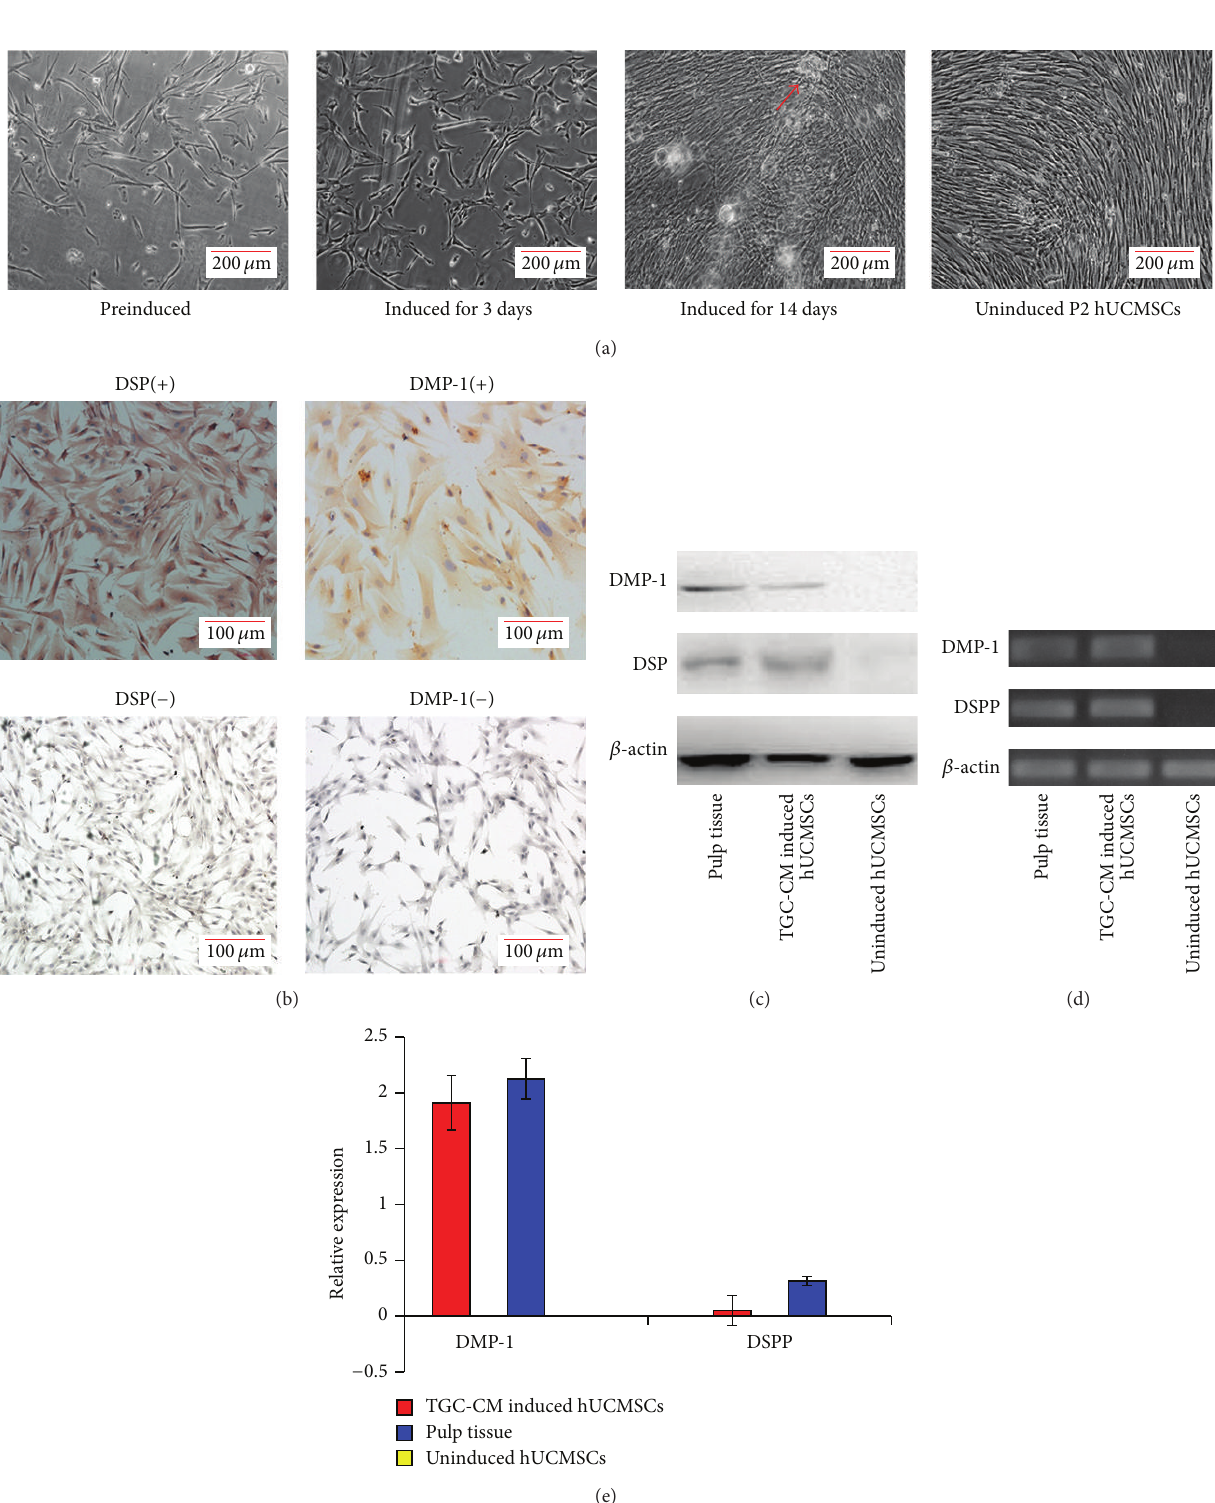
Figure 2: TGC-CM induces hUCMSCs into odontoblast-like cells in vitro . (a) After hUCMSCs were induced in TGC-CM for 3 days, there was little change in the cell morphology. After 14 days, the TGC-CM-induced hUCMSCs grew well and calcified areas were observed (arrow), but the morphology was similar to uninduced cells. (b) Odontoblast marker proteins DSP and DMP-1 were detected in TGC-CM-induced hUCMSCs by immunocytochemistry, but not in uninduced hUCMSCs. (c) Western blotting showed that TGC-CM-induced hUCMSCs and pulp tissue expressed DMP-1 and DSP, whereas uninduced hUCMSCs did not express these proteins. (d) and (e) Relative mRNA levels of DMP-1 and DSPP were determined by quantitative